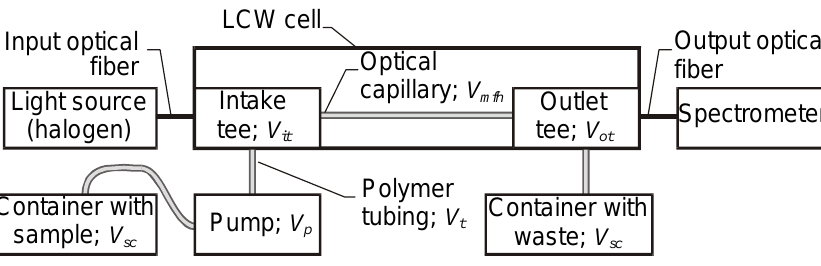
Figure 3. Microfluidic system with an LCW